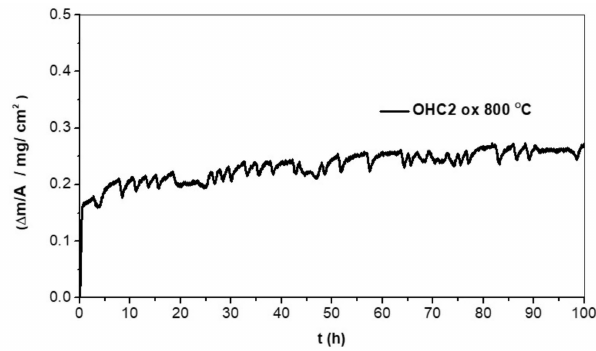
Figure 7. TGA data for isothermal oxidation in air at 800 ◦ C for 100 h.